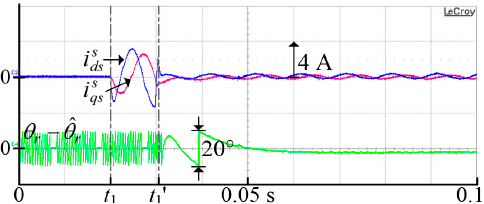
Figure 20. Currents and position errors during restarting period when the current controller BW was set to 500 Hz.